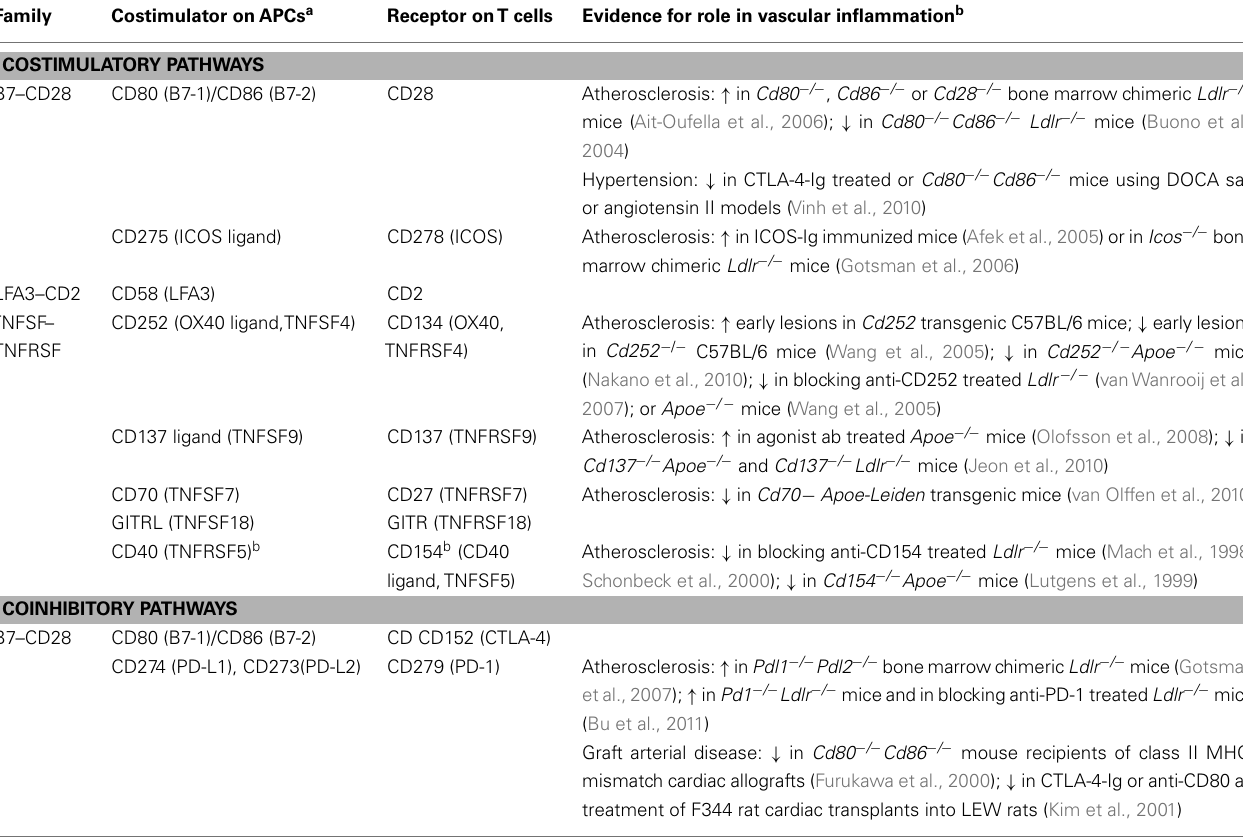
Table 1 | Selected majorT cell costimulatory and coinhibitory